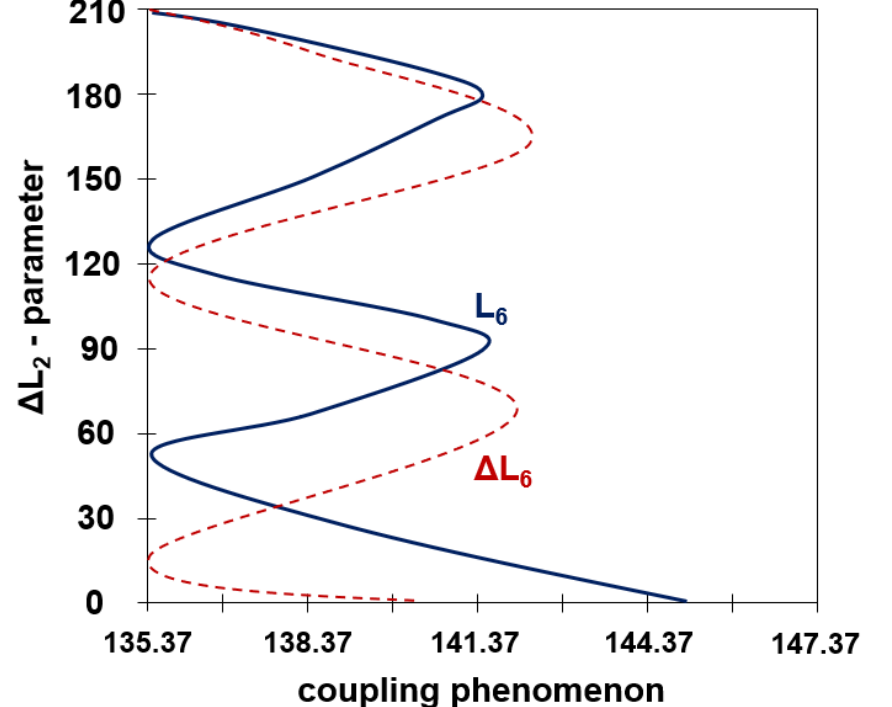
Figure 4. Coupling phenomenon corresponding to the variation of wire length (ΔL 2 ). Table 1. Relationship between the length and the